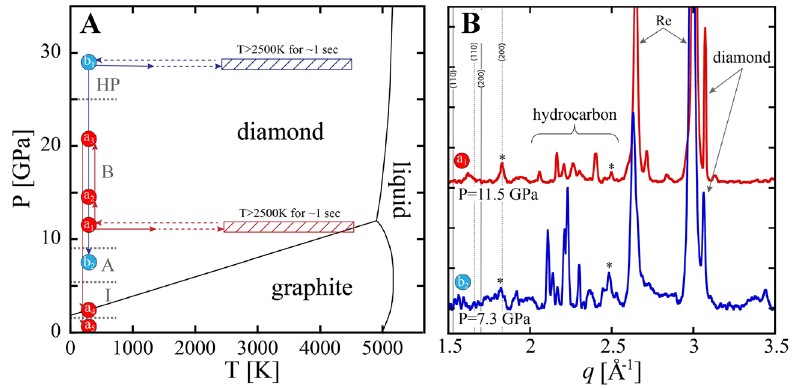
Figure 1. ( A ) Pressure and temperature trajectories for two decompositions of HDPE relative to the carbon phase diagram 13, 14 . HDPE was initially compressed to either 11.5 GPa (‘a’ series, red) or 29.0 GPa (‘b’ series, blue) before heating to decomposition at T > 2500 K for ~ 1 s. Following decomposition, ambient T XRD and SAXS measurements were performed over a series of pressures, denoted by circles a 1 -a 5 (red) and b 1 -b 2 (blue). Horizontal dashed lines indicate the ambient T phase boundaries for solid methane crystal structures I, A, B, and HP 1 . ( B ) Representative XRD patterns showing peaks corresponding to diamond and hydrocarbon products after heating HDPE to > 2500 K at 11.5 GPa (red, a 1 ) and after heating to > 2500 K at 29.0 GPa and subsequent pressure release to 7.5 GPa (blue, b 2 ). The two high intensity peaks correspond to the Re gasket and stars denote peaks corresponding to ruby. For reference, positions of HDPE (110) and (200) peaks at ambient conditions (solid lines) and at P = 15 GPa, T = 300 K (dashed lines) are at lower q than the peaks assigned to hydrocarbon products 15